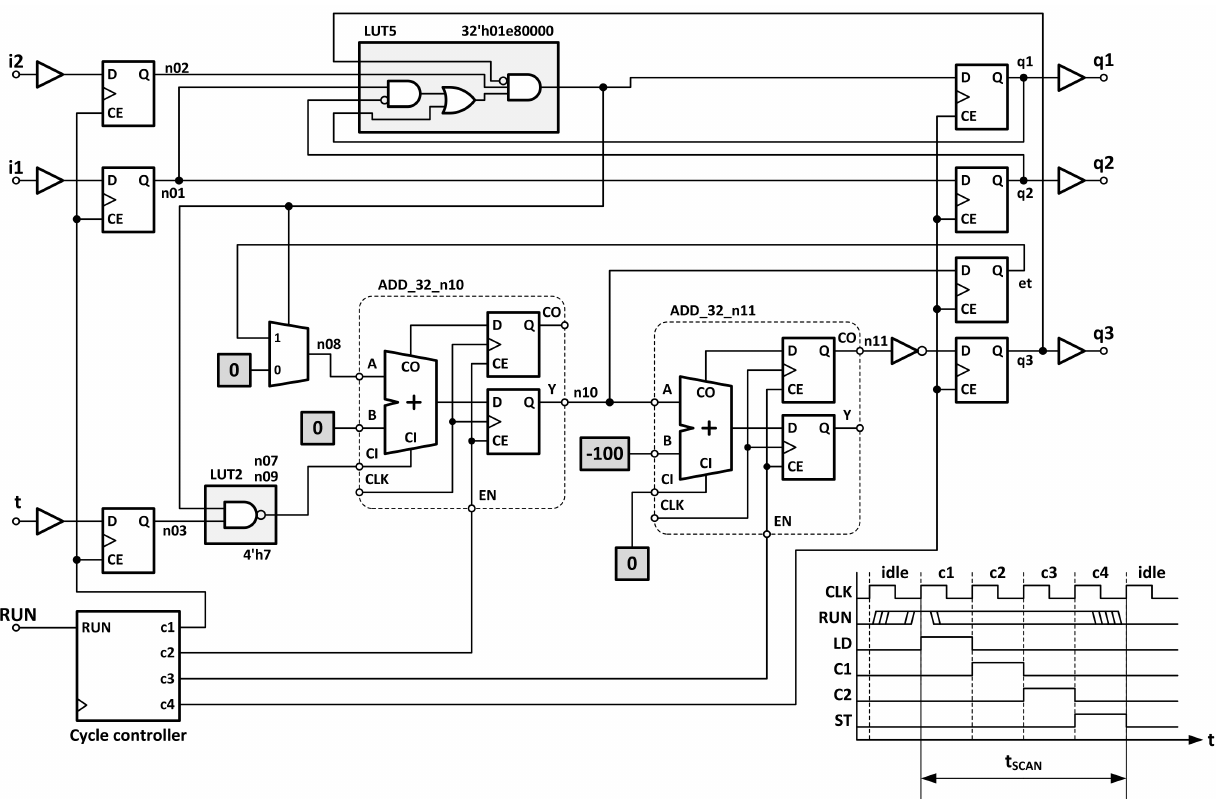
Figure 15. The register transfer level block diagram of the hardware mapping of the exemplary LD